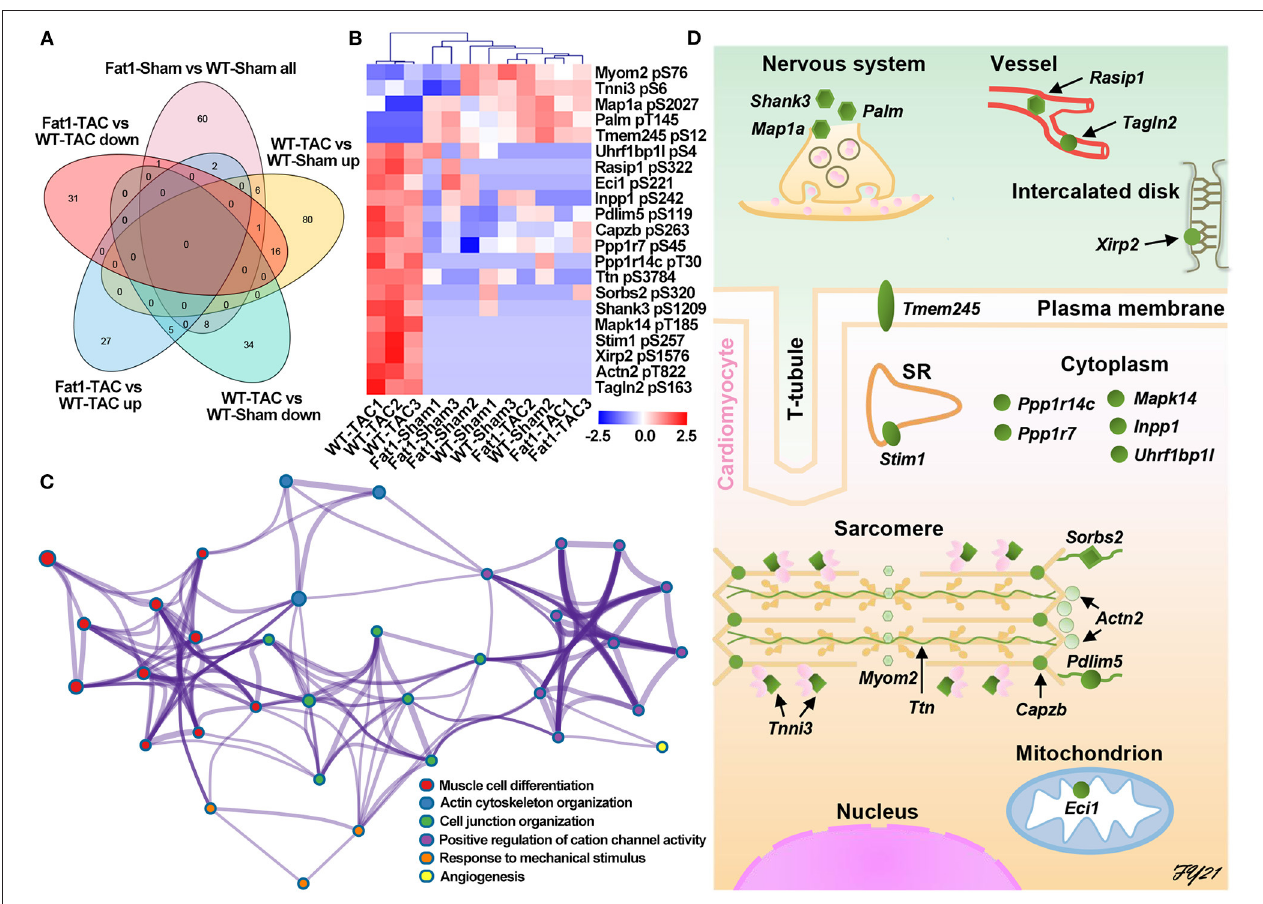
FIGURE 4 | Protein phosphorylation affected by fat-1 transgene in pressure overload hearts. (A) Venn diagram analysis; (B) DEPs affected by fat-1 transgene under pressure overload conditions. (C) Elevated endogenous N-3 PUFAs suppressed phosphorylation signaling pathways that induce cardiac remodeling and alterations of ion hemostasis. (D) The location of each phosphoprotein is identified in the schematic illustration of the cardiomyocyte and its surrounding tissues, showing that endogenous n-3 PUFAs can function to plasma membrane, sarcomere reticulum (SR), cytoplasm, sarcomeres, and mitochondria of the cardiomyocytes, as well as the nerves and vessels. N = 3 per